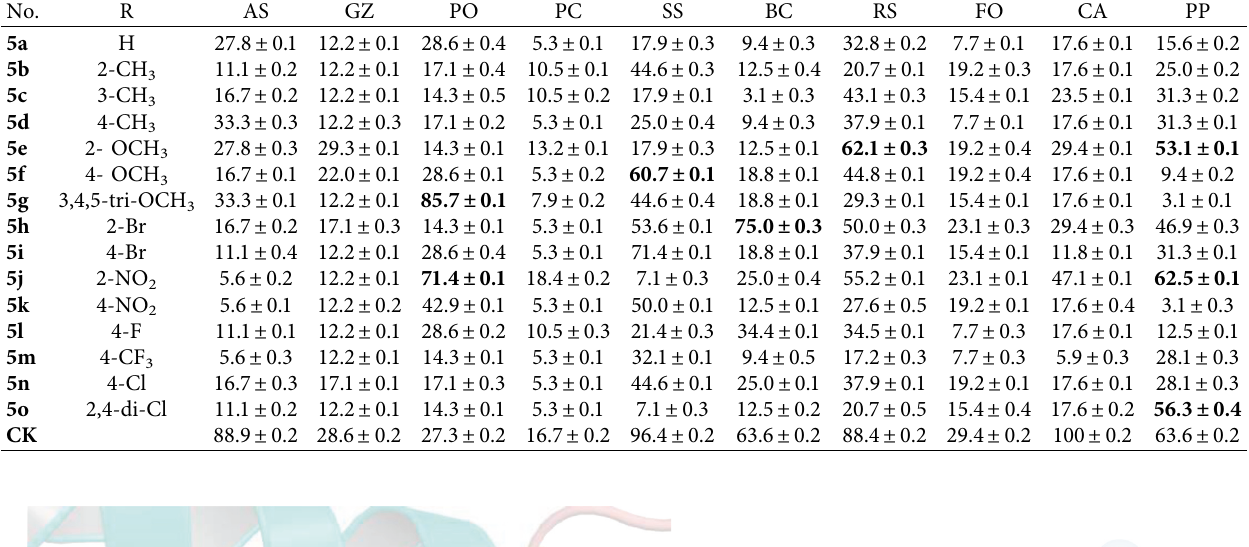
Table 2: The fungicidal activity of compounds 5a ∼ 5o at